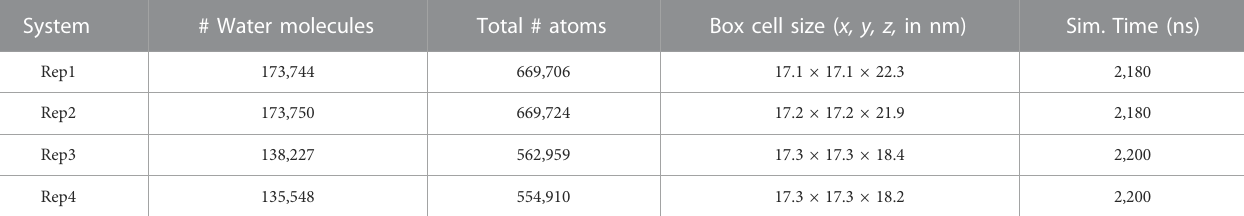
TABLE 1 Protein-membrane simulation systems.